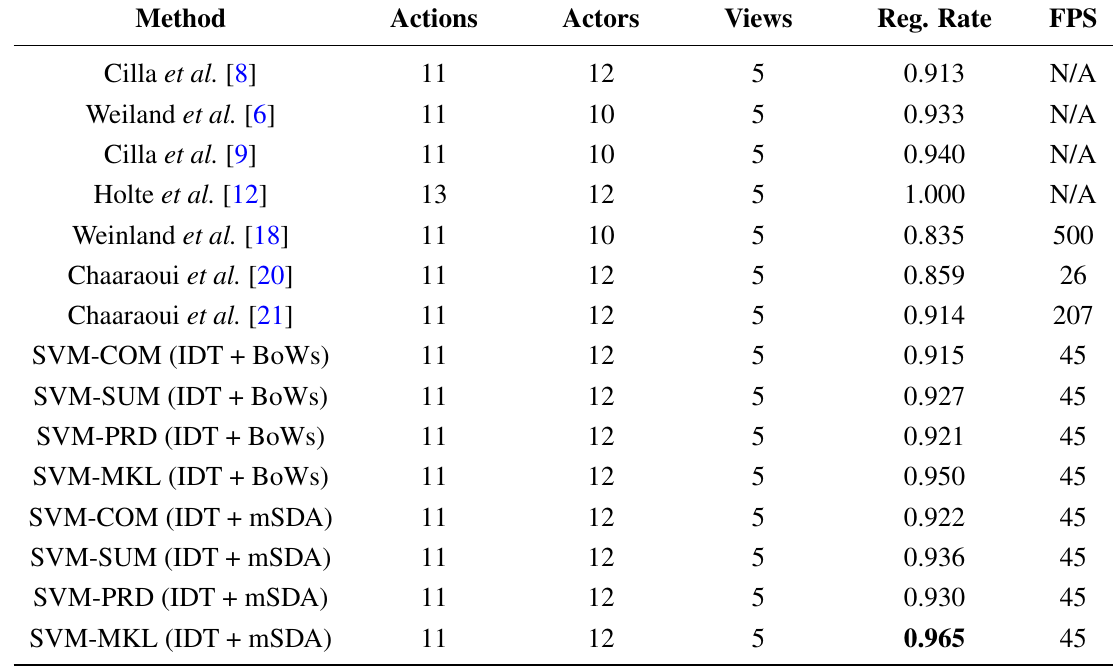
Table 1. Comparison of all the methods in this work using IDT descriptor and BoWs or mSDA on the original IXMAS dataset, where the methods with “N/A” in the FPS column are offline